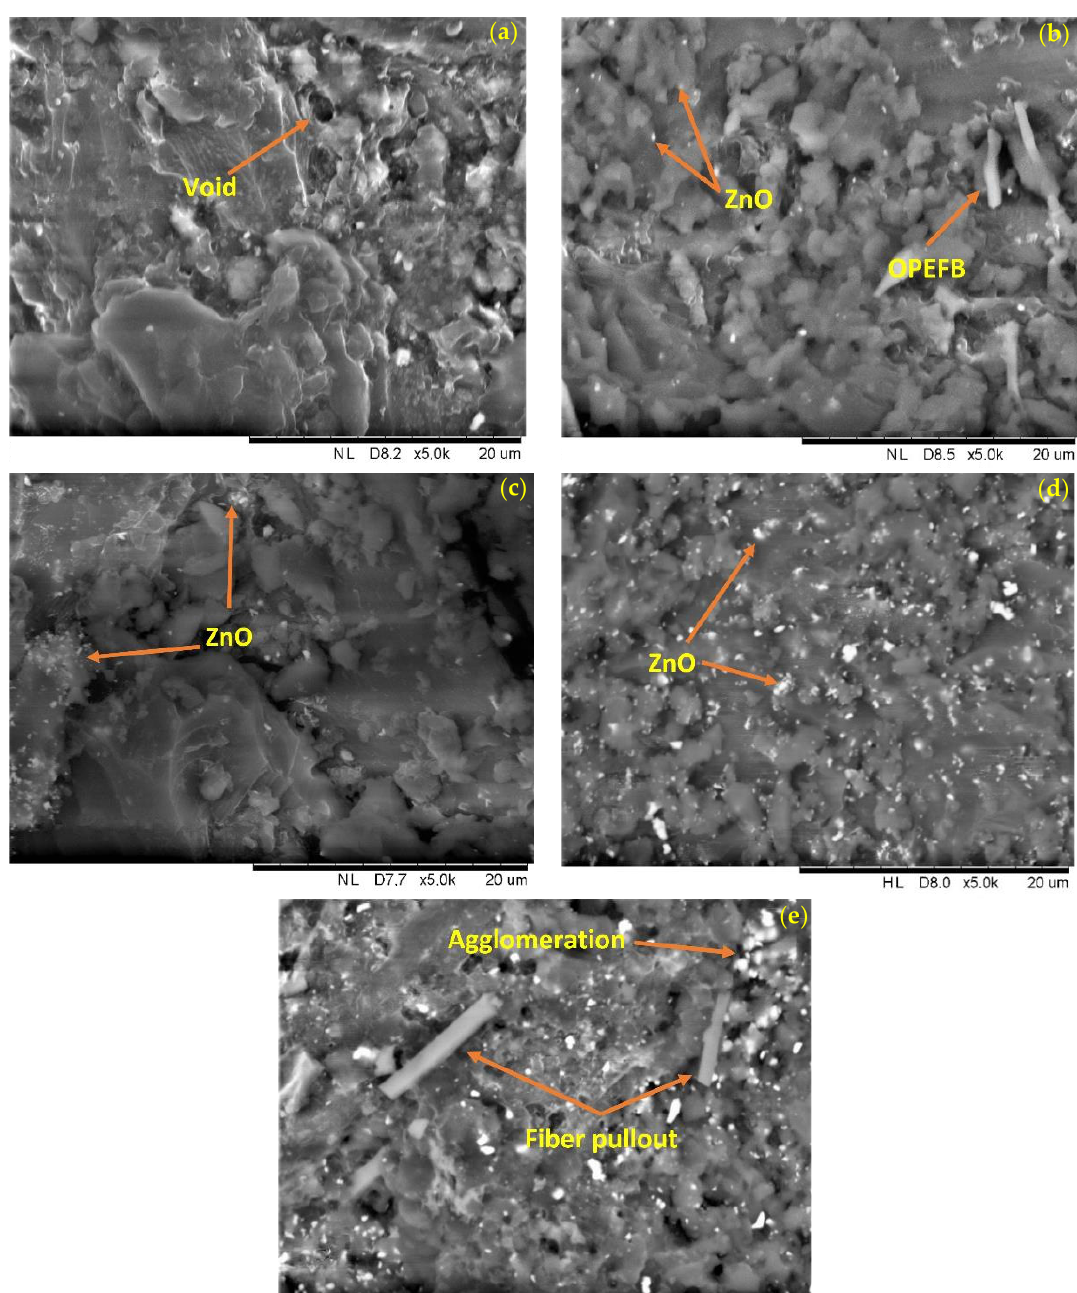
Figure 6. Surface morphology of foamed polymer composites at different ZnO fillers, ( a ) 0% ZnO, ( b ) 5% ZnO, ( c ) 10% ZnO, ( d ) 15% ZnO, ( e ) 20% ZnO.